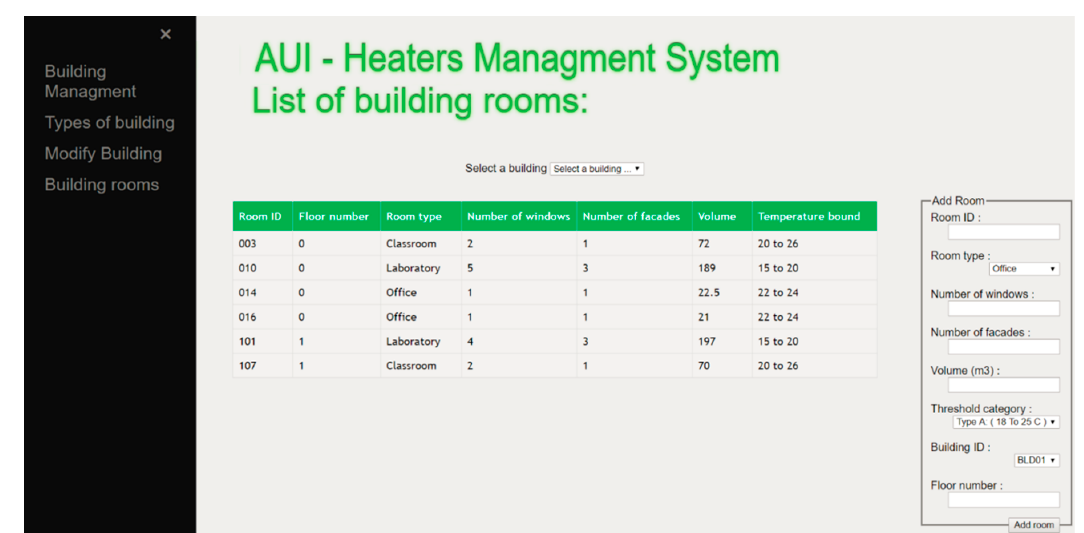
Figure A3. Rooms of building 7 where the EMS was implemented.